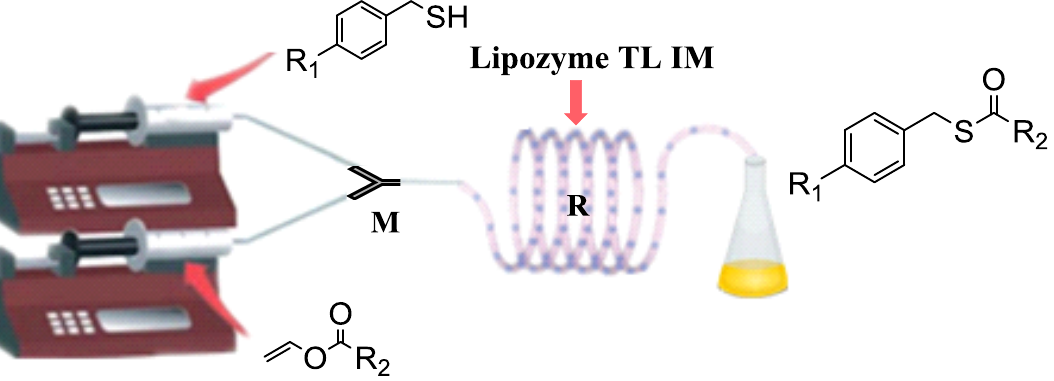
Figure 1. Experimental setup for the synthesis of thioesters catalysed by Lipozyme TL IM from Thermomyces lanuginosus in a continuous-flow microreactor.